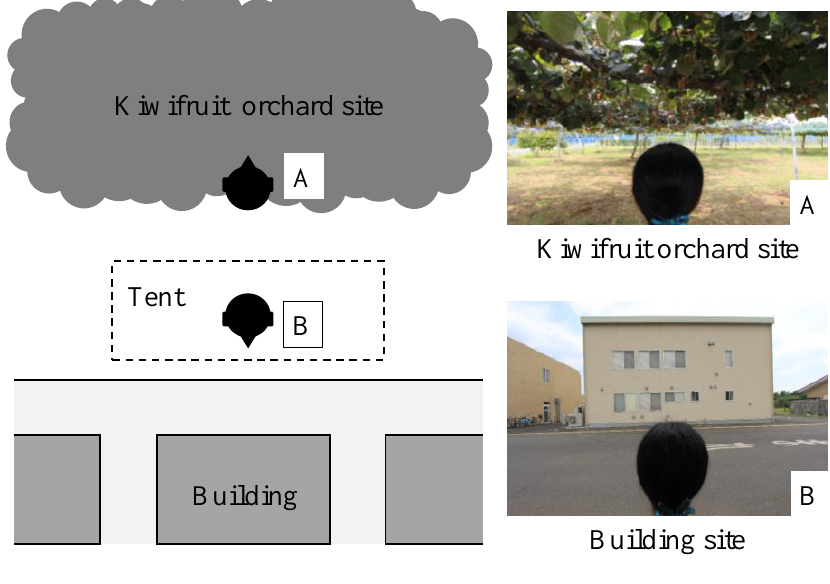
Figure 1. Schematic and photographs showing the two scenes that were